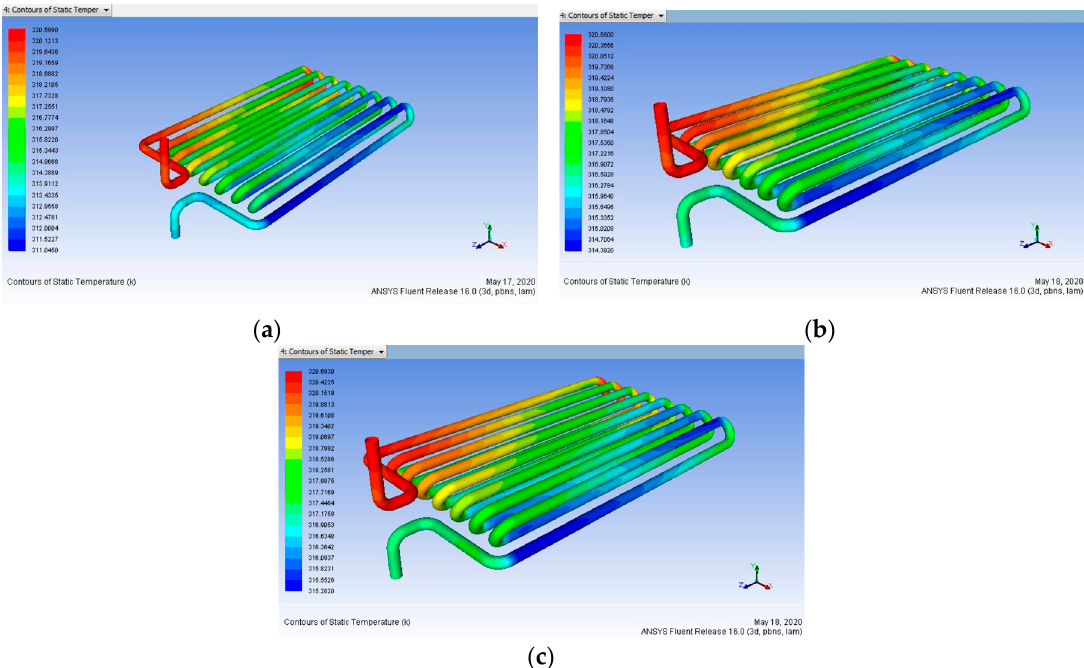
Figure 11. Heat input 323 K vs. mass flow rate ( a ) 0.15, ( b ) 0.30, ( c ) 0.45 L / min (Before Coating).